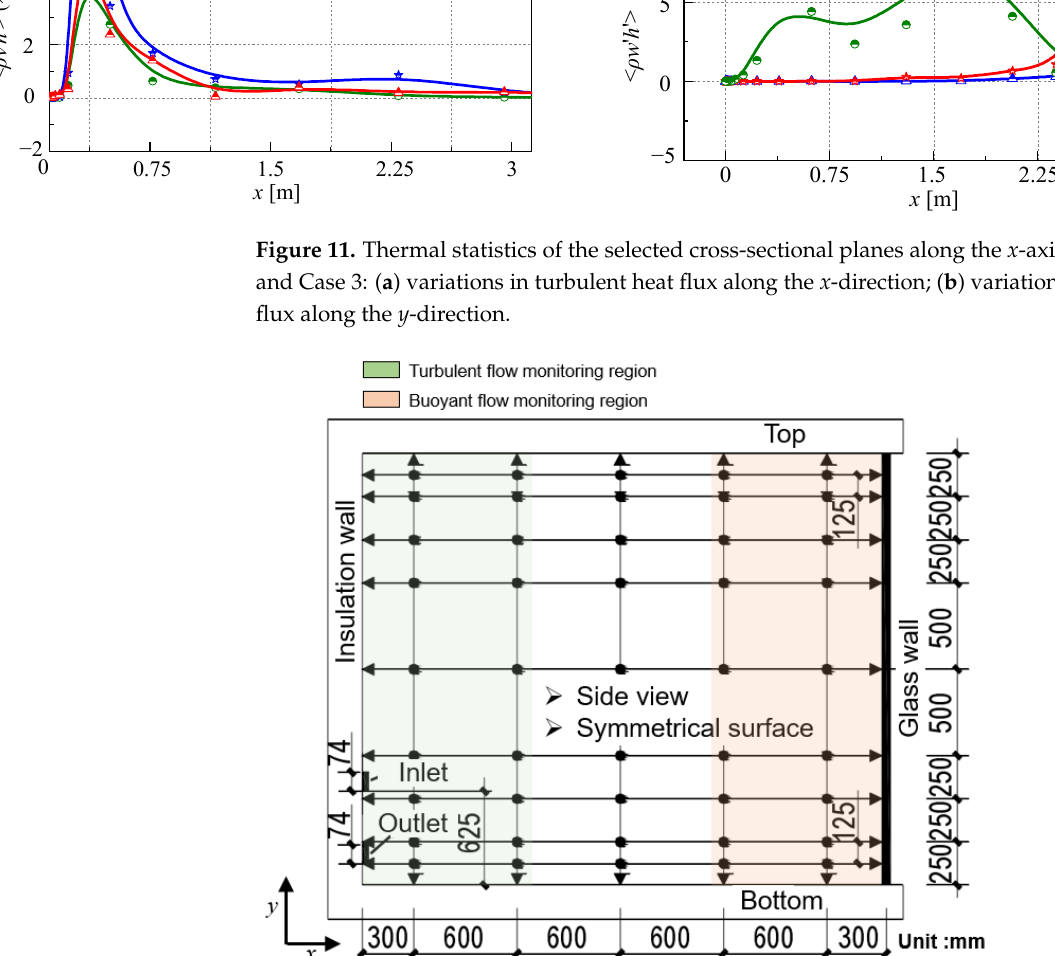
Figure 12. Arrangement of points for monitoring indoor space radiation. Under the same operating conditions, the glass wall surface temperature was considerably higher than the indoor radiation temperature, and the difference between the two temperatures determined the flow of radiation. As displayed in Figure 13, the difference between the glass wall surface temperature and the radiation temperature in Case 1 was large because of the low entrance temperature. As displayed in Table 2, the constant temperature of the glass wall surface was 20 ◦ C.